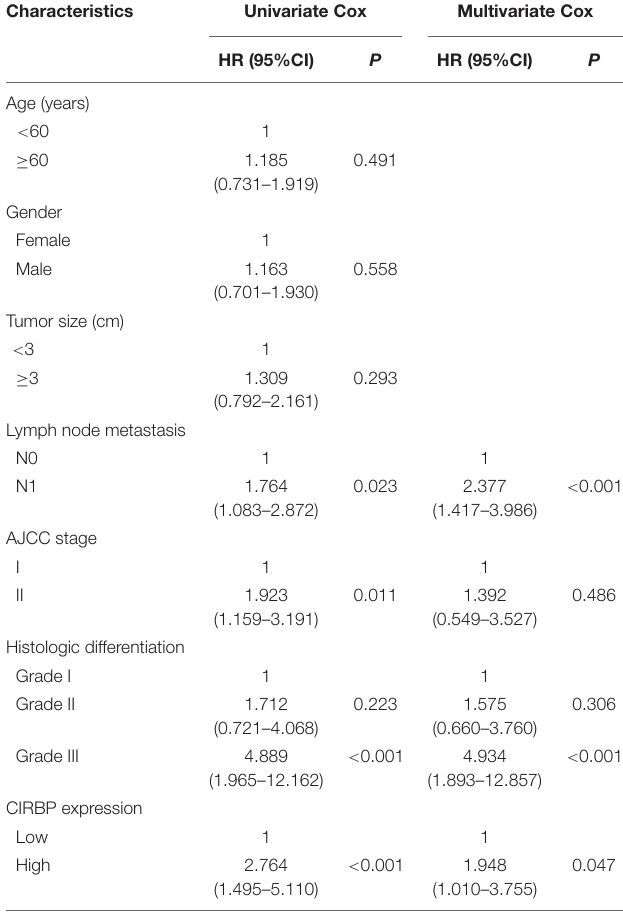
TABLE 2 | Univariate and multivariate Cox regression analysis of 90 pancreatic cancer patients.